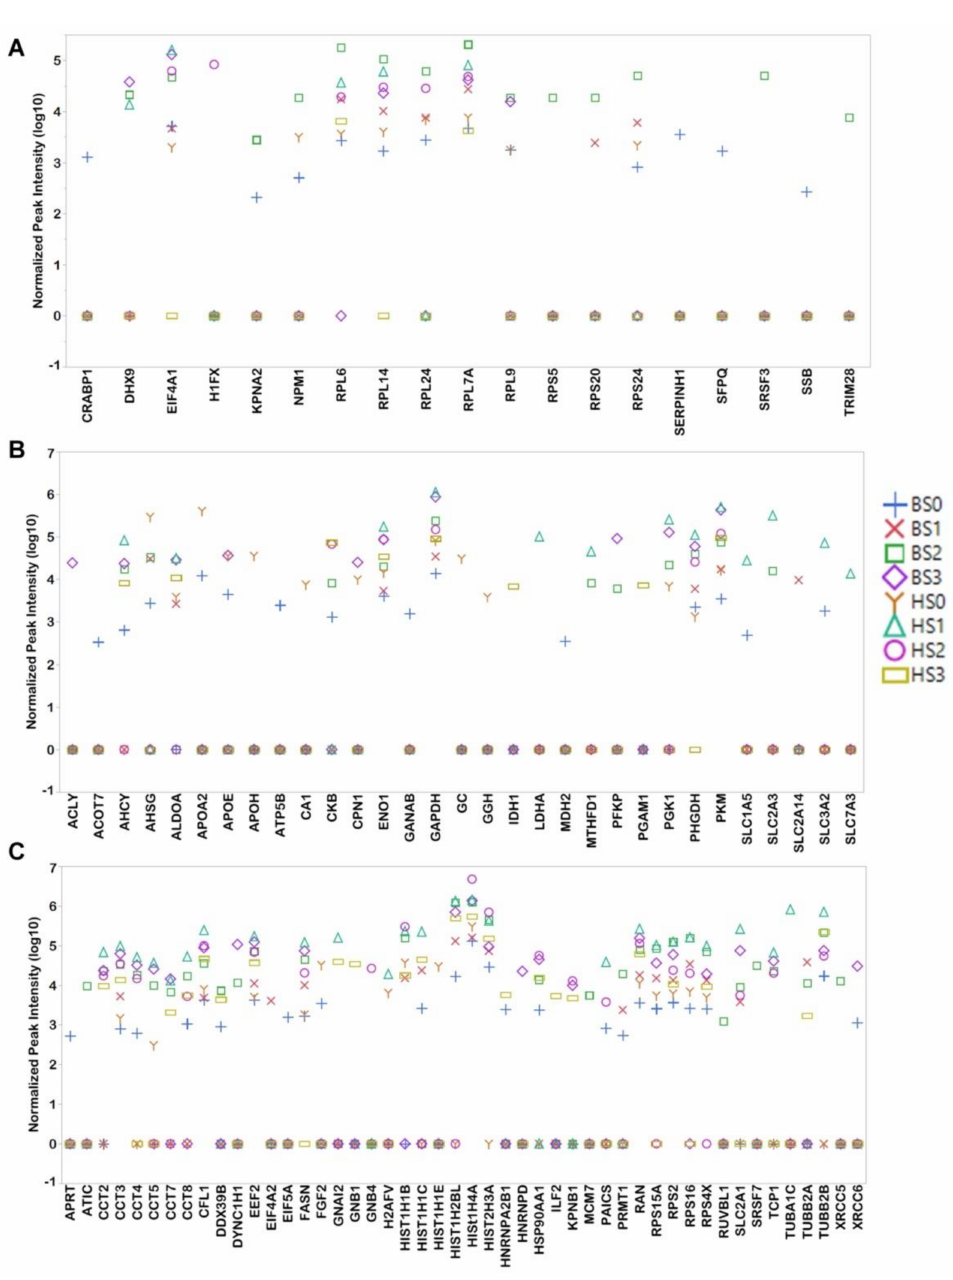
Figure 5. Relative abundance of proteins in exosomes from hPSCs undergoing differentiation toward CMs. Scatterplots of ( A ) pluripotency-, ( B ) metabolic-, and ( C ) proliferation-related proteins. The points are denoted by the hPSC line (B: B12-3, H: H9) followed by the stage of differentiation. For instance, HS2 corresponds to differentiation stage 2 for exosomal samples from H9 cells. Zero peak intensity means that a protein was not detected in a